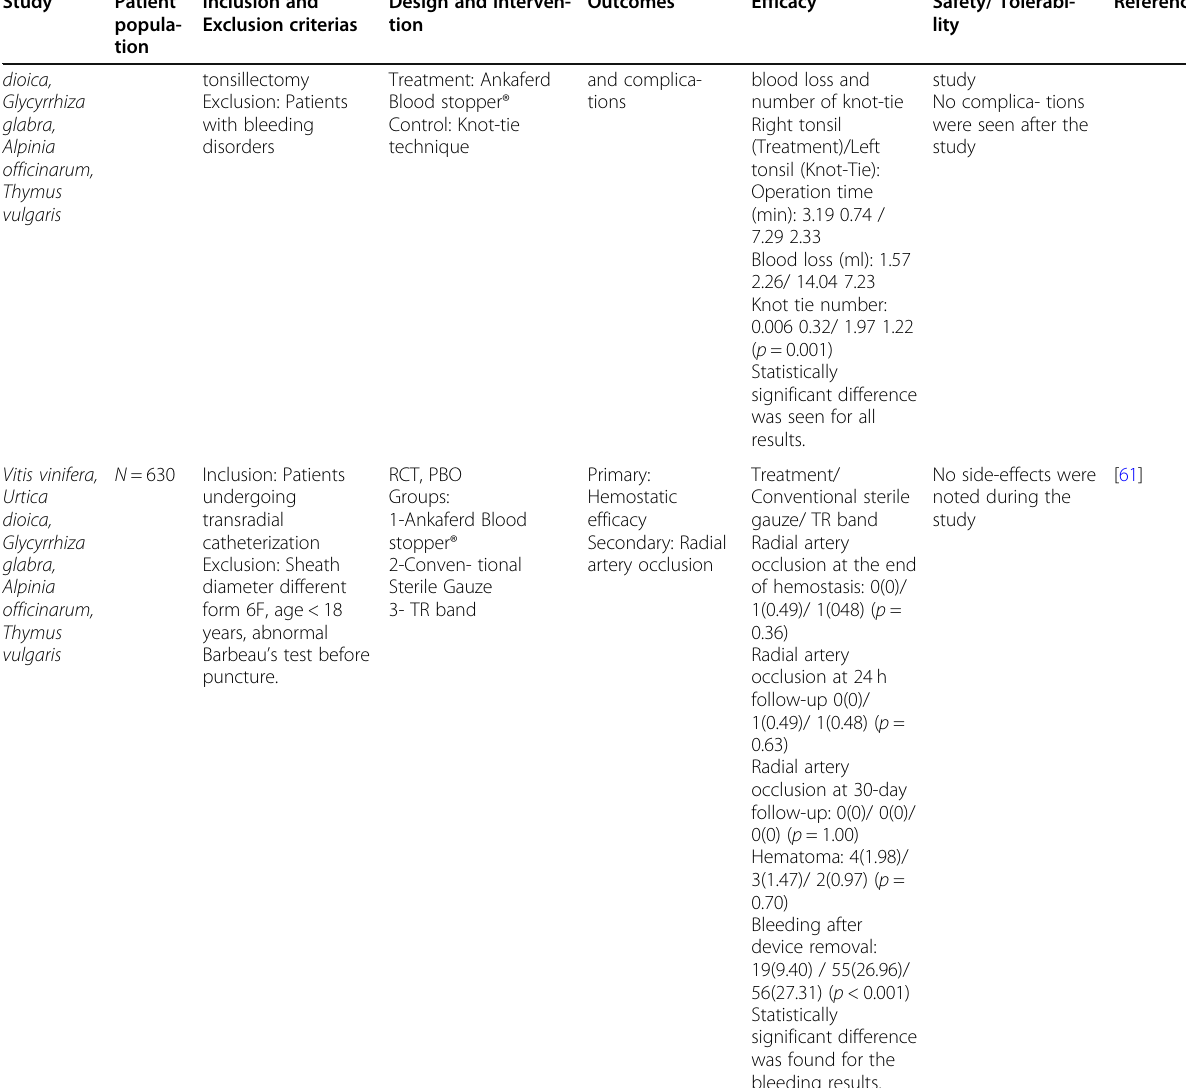
Table 4 Clinical trials of the traditional plants used for skin problems in Turkey (Continued)